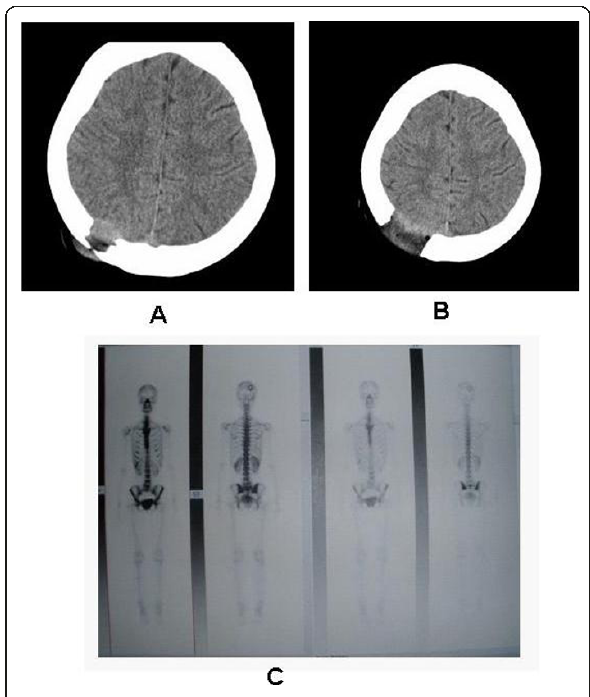
Figure 2 Metastatic tumor of the right parietal bone . A: CT scan of the brain shows that the right parietal bone is ruined before the craniectomy. B: CT scan of the brain after craniectomy. C: The emission-computed tomography scan shows an abnormal distribution of radioactivity in the right parietal bone area; the sparse distribution of radioactivity was central; peripheral distribution of radioactivity uptake before craniectomy.